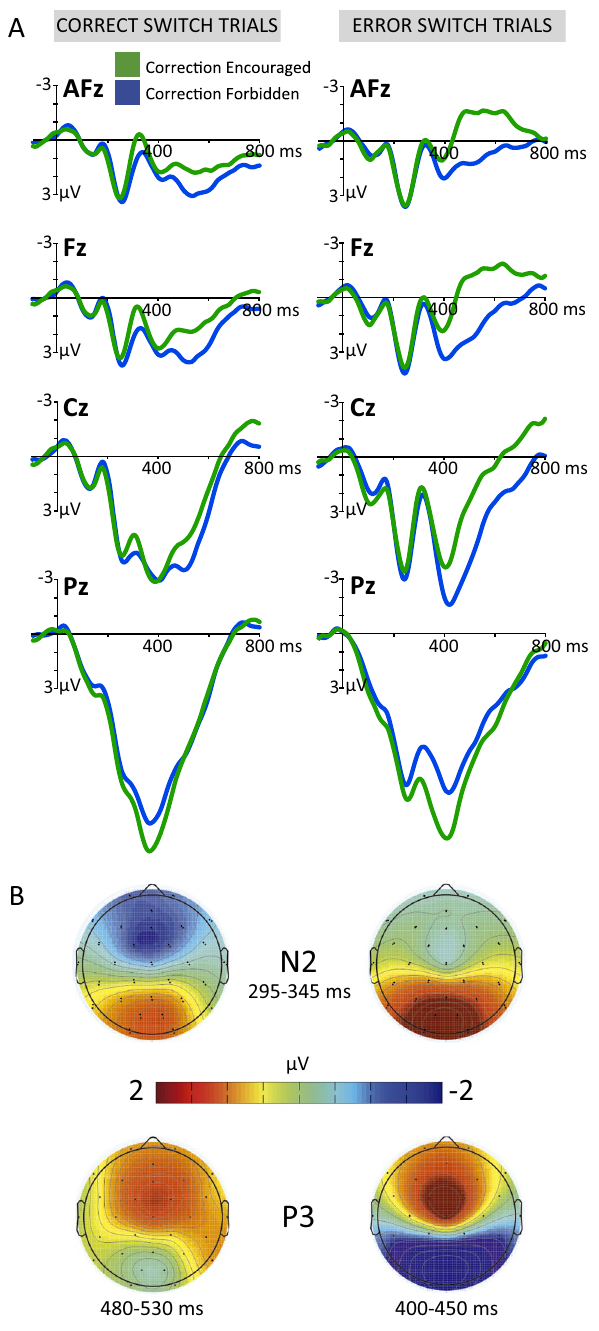
Figure 3. ( A ) S-locked grand average from midline electrodes for correct (left) and error (right) switch trials, separately for the Encouraged (green) and Forbidden (blue) correction conditions. ( B ) Topographical mapping of N2 and the P3